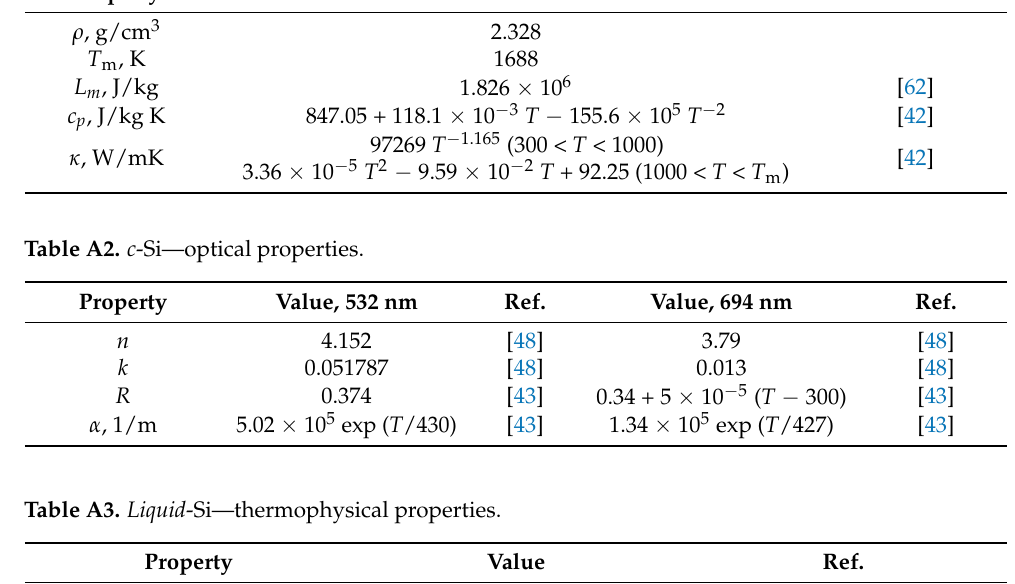
Table A1. c -Si—thermophysical properties. Property